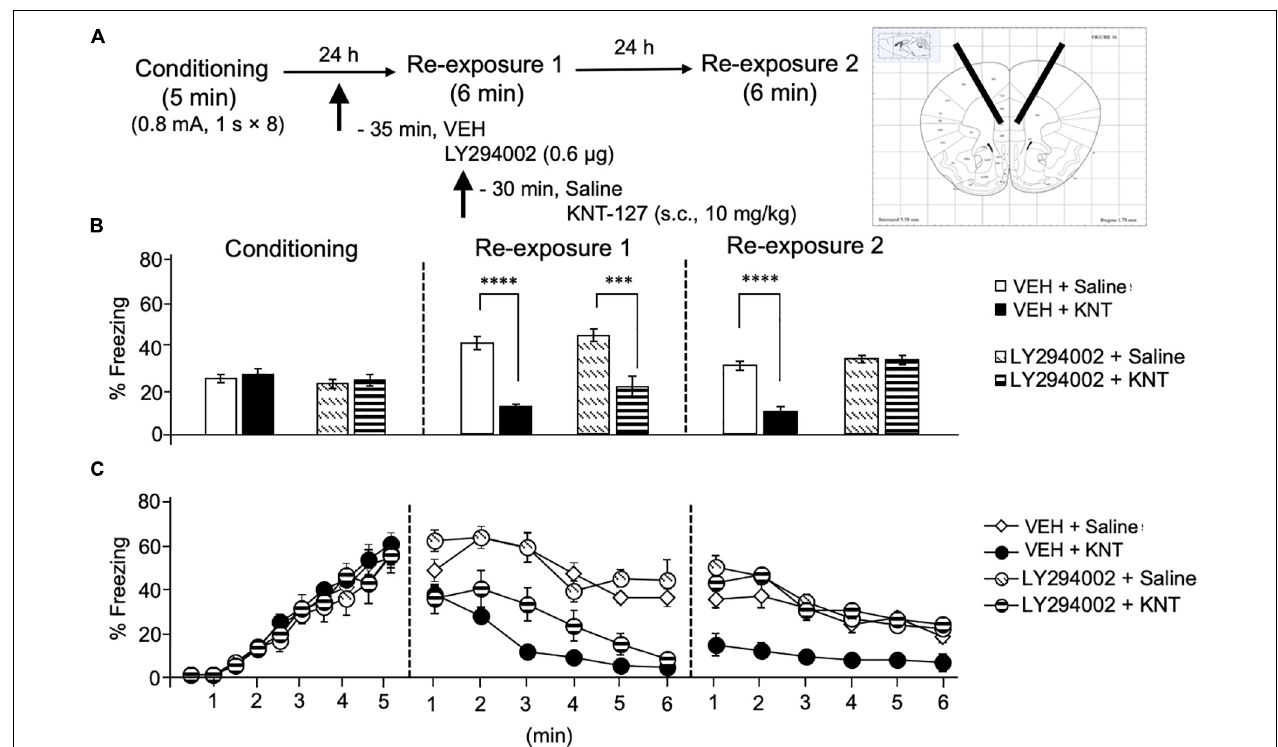
FIGURE 6 | Intra-IL administration of the PI3K/Akt inhibitor abolished the fear-reducing effect of KNT-127. (A) Experimental design. Mice were subcutaneously administered with saline or KNT-127 (10 mg/kg) 30 min before reexposure 1 (6 min). Five minutes before injecting these drugs, a vehicle or a PI3K inhibitor, LY294002, was administered bilaterally into the IL (35 min before reexposure 1). Twenty-four hours after reexposure 1, a fear memory was tested in the same context for 6 min (reexposure 2). (B) Freezing rates of mice during conditioning, reexposures 1 and 2. LY294002 abolished the effect of KNT-127 during reexposure 2. The number of mice in each group was as follows: n = 6 for vehicle and subsequent saline (VEH + saline), n = 5 for vehicle and subsequent KNT-127 (VEH + KNT), n = 5 for LY294002 and subsequent saline (LY294002 + saline), and n = 6 for LY294002 and subsequent KNT-127 (LY294002 + KNT). (C) Time course of the freezing rates of mice during conditioning, reexposures 1 and 2. Data are expressed as the means ± SEM. Data were expressed as mean ± SEM. ∗∗∗ p < 0.001, ∗∗∗∗ p < 0.0001 for comparisons between KNT-127 and LY294002 treatment groups, by two-way ANOVA and post hoc Bonferroni’s